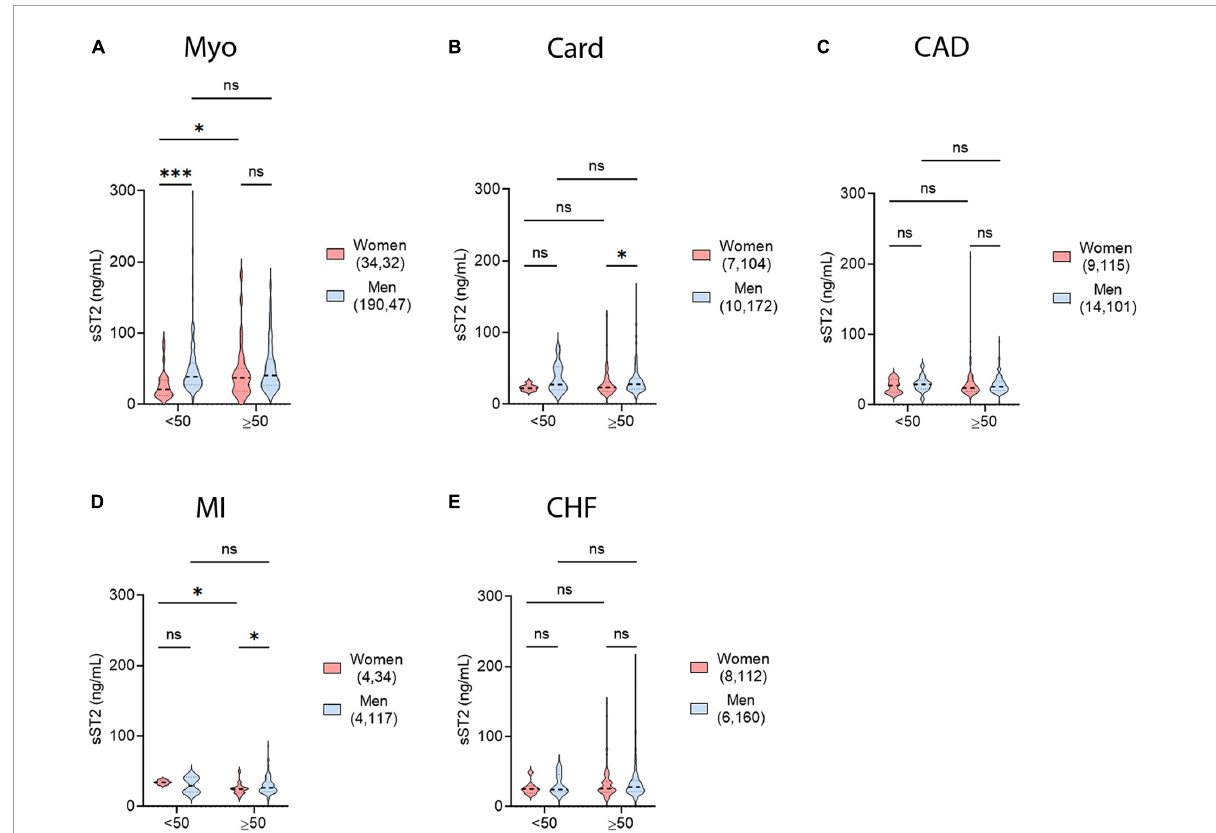
FIGURE3 Sex and age differences in sST2 in CVDs. sST2 levels compared women (peach) vs. men (blue) that were < 50 vs. ≥ 50 years of age for (A) myocarditis (Myo), (B) cardiomyopathy (Card), (C) coronary artery disease (CAD), (D) myocardial infarction (MI), or (E) congestive heart failure (CHF). Violin plots denote data distribution for each group. One-way ANOVA: (A) p = 0.0043, (B) p = 0.035, (C) p = 0.94, (D) p = 0.16, and (E) p = 0.70 with two-way comparisons analyzed using unpaired Student’s t -test: ∗ , p < 0.05; ∗∗∗ , p < 0.001; ns, not significant. (A) Two-way ANOVA p -values indicate no interaction between sex and age in patients with myo ( p = 0.11), but interactions between sex and sST2 ( p = 0.0047) and age and sST2 ( p = 0.0496). (B) Two-way ANOVA p -values indicate no interactions between sex and age ( p = 0.43) or age and sST2 ( p = 0.99) in patients with card, but interaction between sex and sST2 ( p = 0.04). (C) Two-way ANOVA p -values indicate no interactions between sex and age ( p = 0.60), age and sST2 ( p = 0.79), or sex and sST2 ( p = 0.79) in patients with CAD. (D) Two-way ANOVA p -values indicate no interactions between sex and age ( p = 0.32), age and sST2 ( p = 0.25), or sex and sST2 ( p = 0.92) in patients with MI. (E) Two-way ANOVA p -values indicate no interactions between sex and age ( p = 0.87), age and sST2 ( p = 0.54), or sex and sST2 ( p = 0.57) in patients with